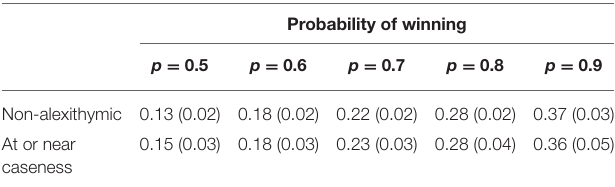
TABLE 2 | Means (and standard errors) of the proportion bet for the alexithymia groups by the probability of winning. Probability of